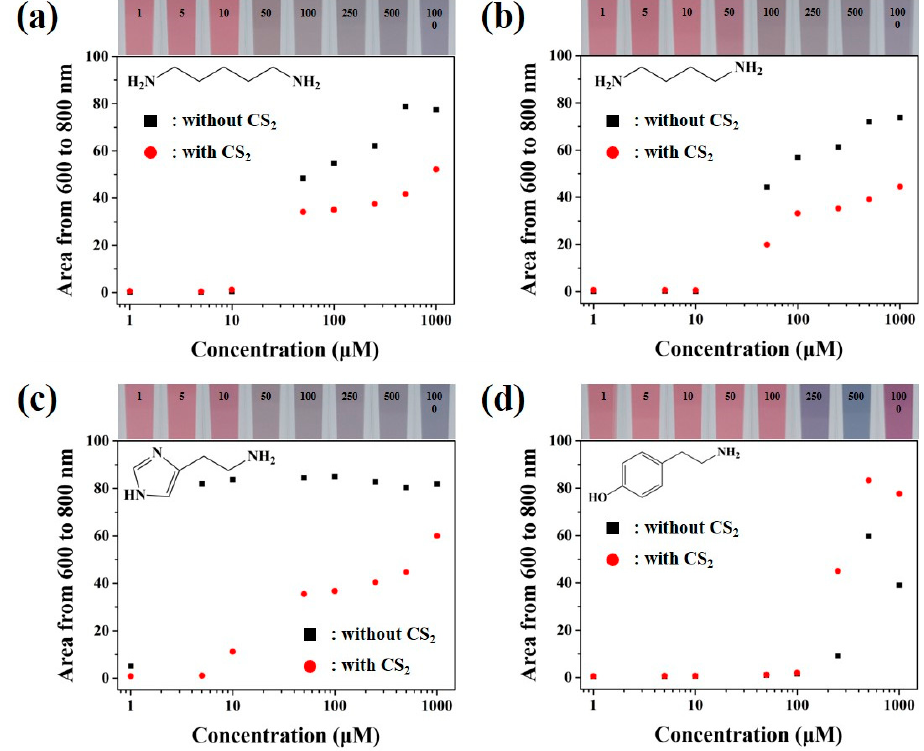
Figure 3. Absorption peaks of BA with various concentrations ( a ) Cad, ( b ) Put, ( c ) Him and ( d ) Trm with visual analysis of colorimetric sensors in the presence of CS 2 for the detection of BA.